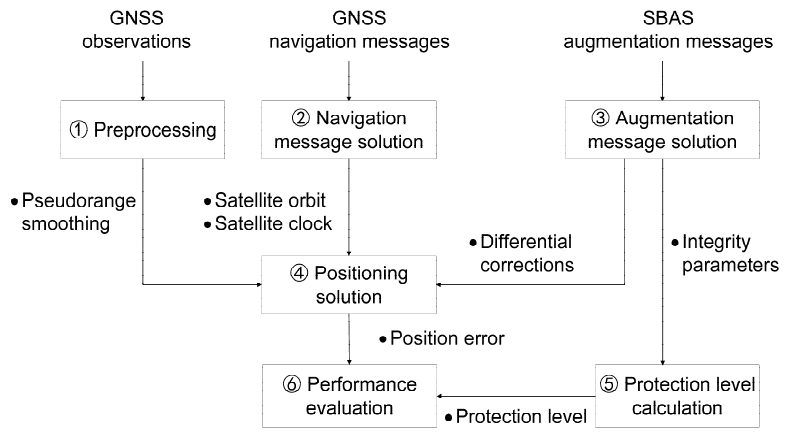
Figure 4. BDSBAS SF solution flow.